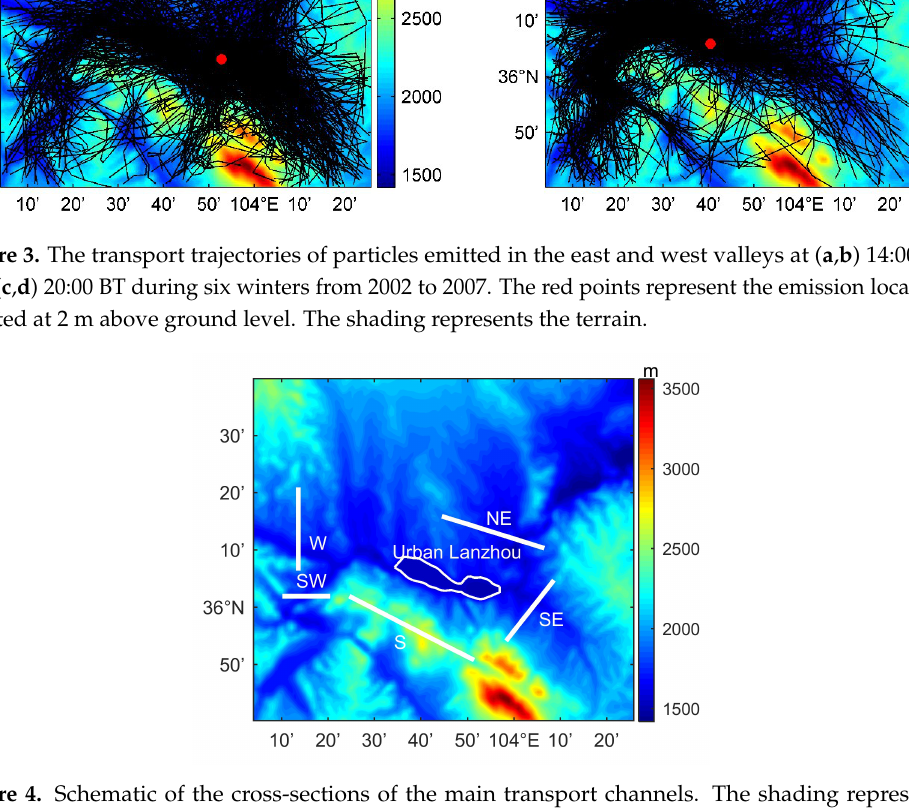
Figure 4. Schematic of the cross-sections of the main transport channels. The shading represents the terrain.